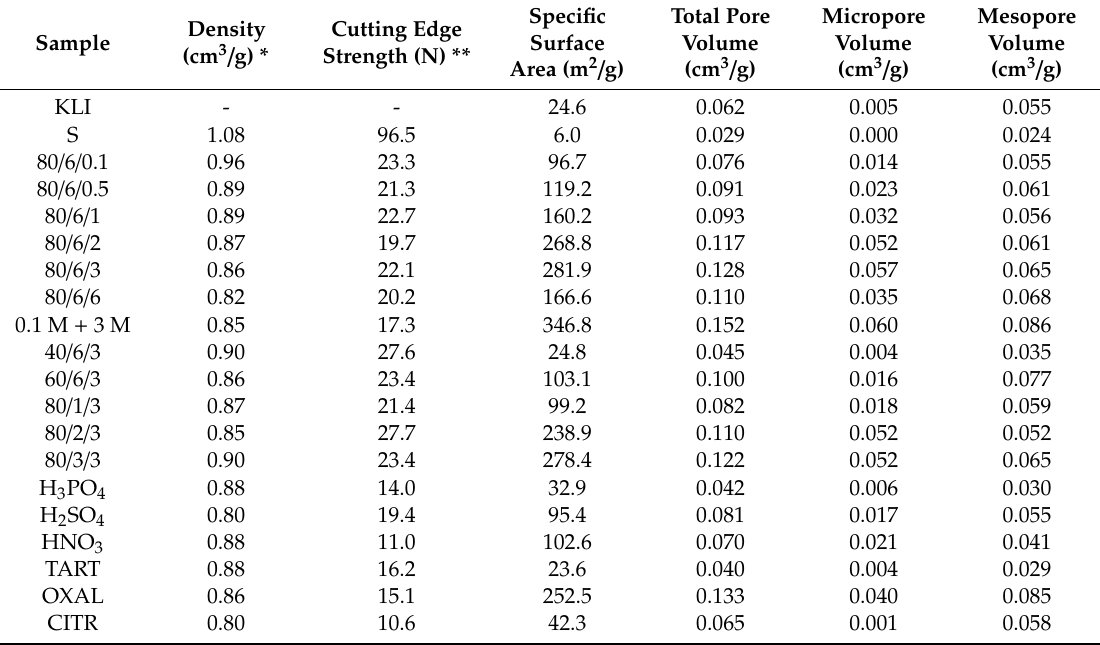
Table 3. Mechanical and textural properties of acid leached zeolite foam